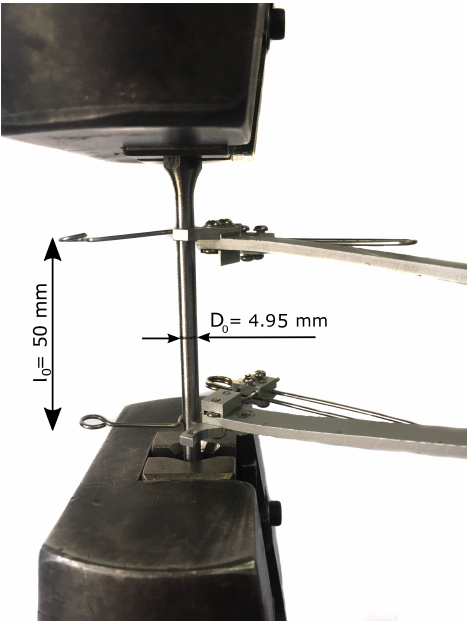
Figure 2. Setup of the tensile test.